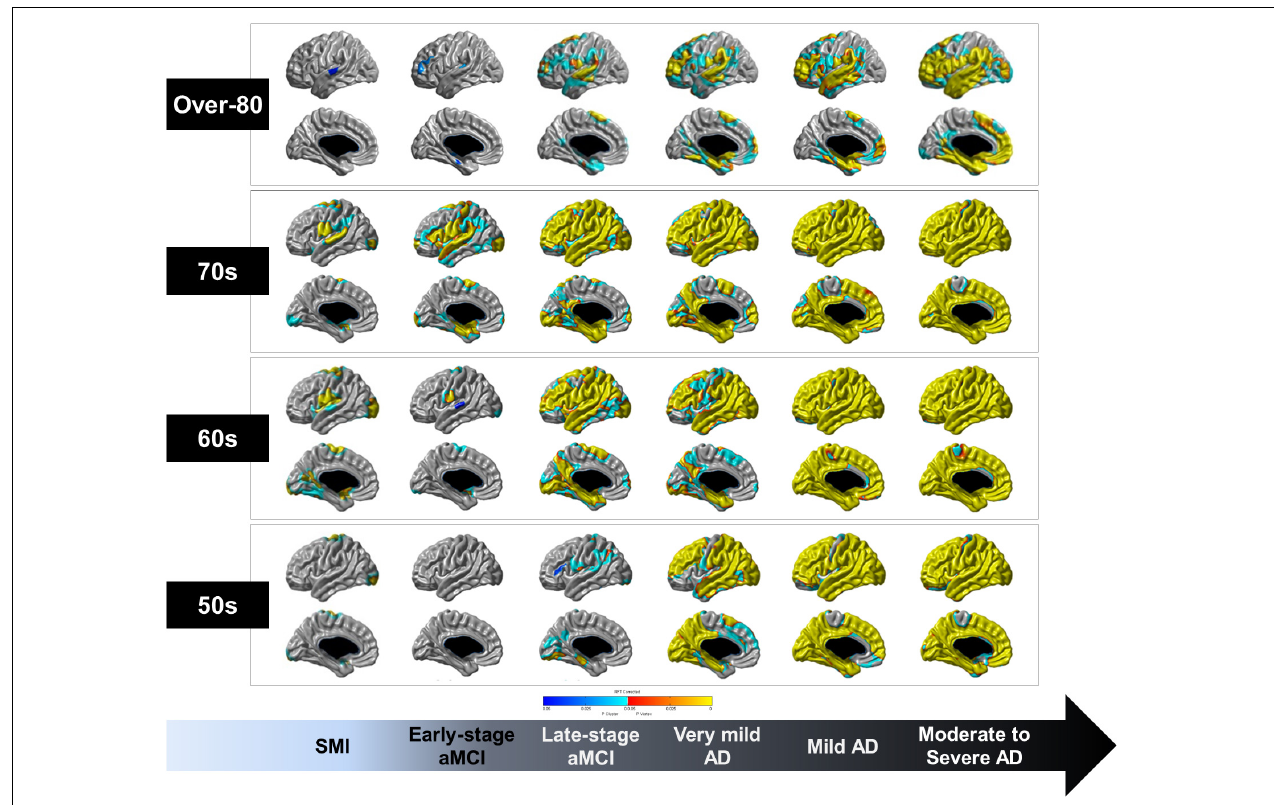
FIGURE 2 | Topographical differences in the cortical thickness of each age group based on the diagnostic groups compared to age group-matched CN individuals. RFT-corrected ( P -value < 0.05) results were adjusted for sex, education years, ICV, vascular risk factors (hypertension, diabetes mellitus, and hyperlipidemia), and history of ischemic heart disease or stroke. The color scale from blue to yellow indicates statistically significant topographical differences in cortical thinning of each age group. CN, cognitively normal; SMI, subjective memory impairment; aMCI, amnestic mild cognitive impairment; AD, Alzheimer’s disease; RFT, random field theory; ICV, intracranial